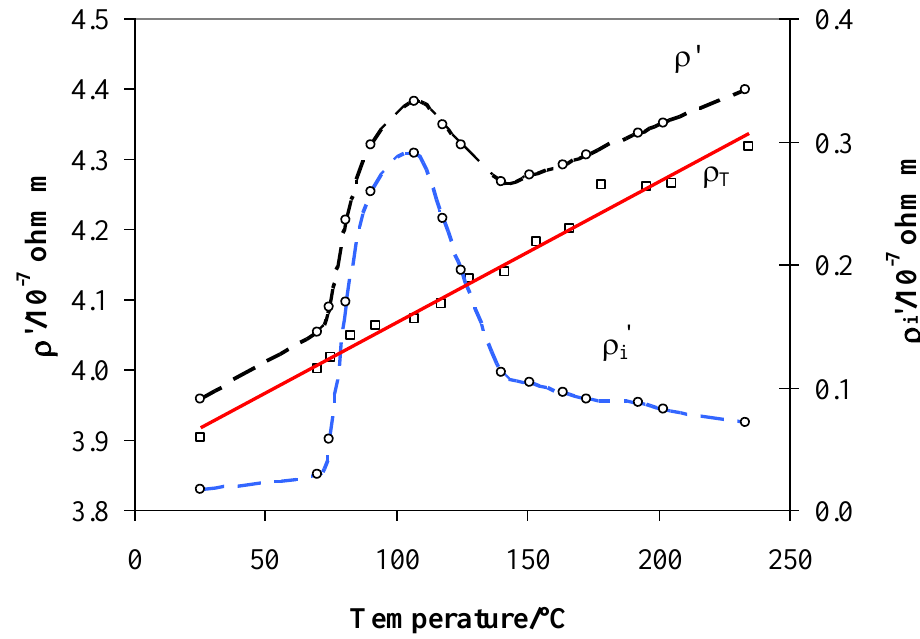
Figure 7. Total resistivity ρ (cid:48) and its contribution due to the scattering ρ i (cid:48) of Pd 79 –Ag 21 foil measured after the vacuum step at di ff erent temperatures.